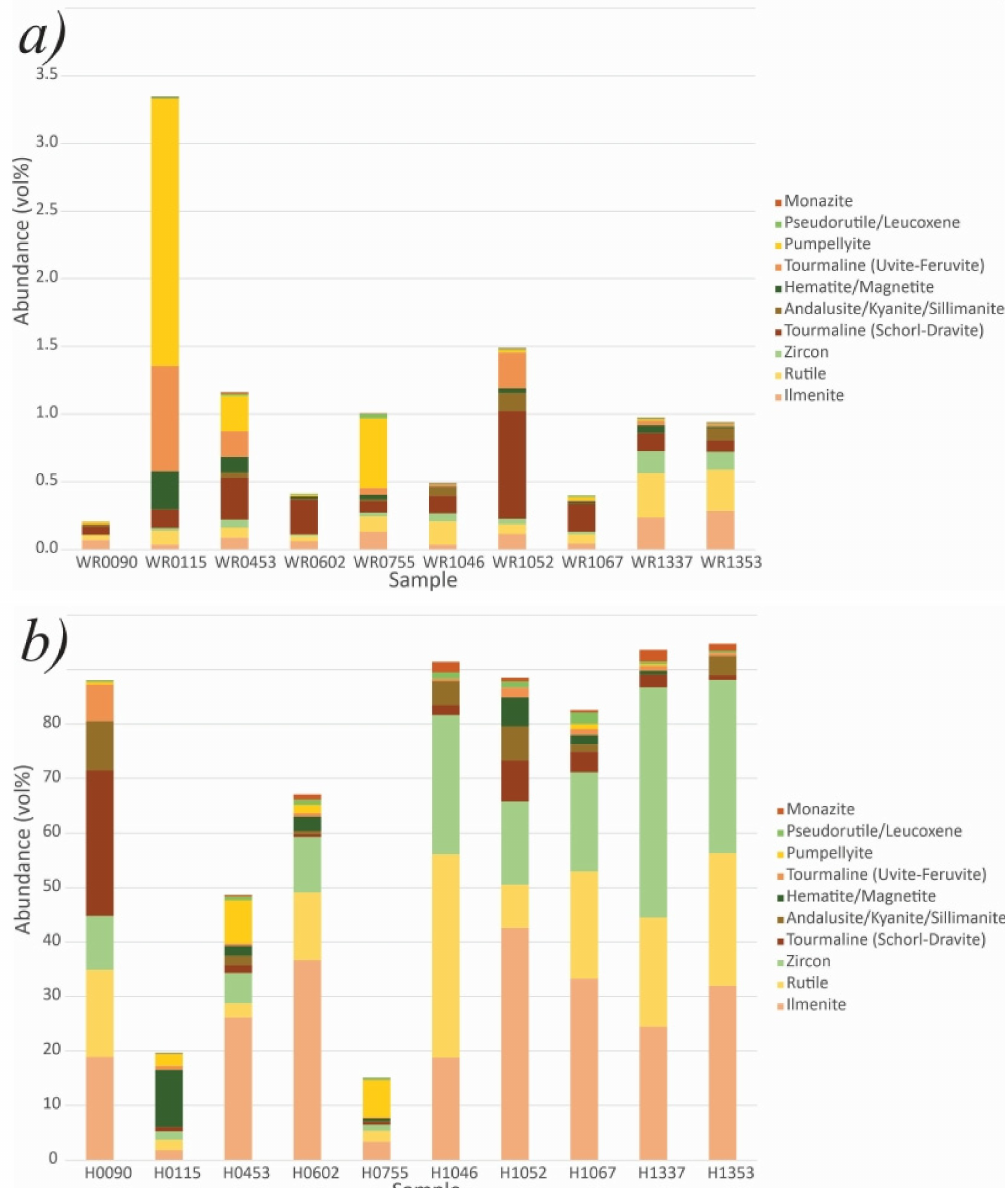
Figure 2. Stacked bar diagrams of the abundances (vol%) of 10 selected heavy minerals in the whole rock (prefix WR) ( a ), and heavy mineral (H) ( b ) fractions of the 10 NGSA samples (identified by last four-digit code). Please refer to Table S2 in Supplementary Materials for the full list of identified